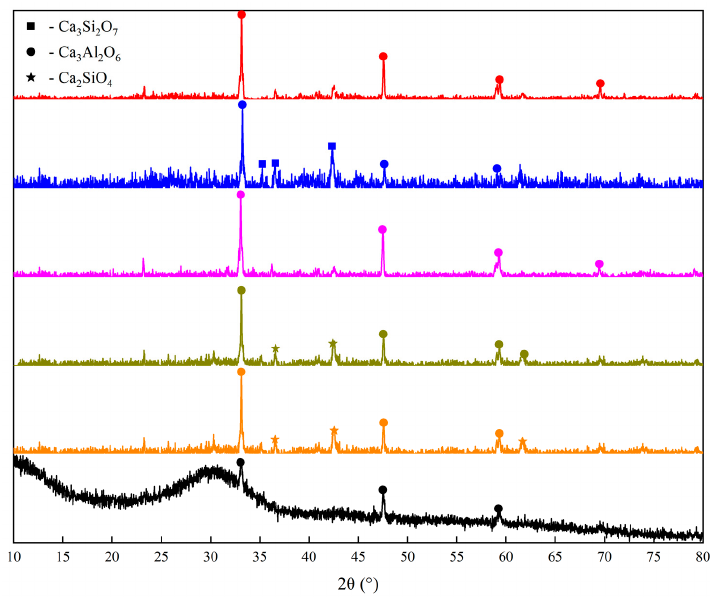
Figure 5. XRD pattern of the slag after pyrolysis (BFS-P) and original BFS.